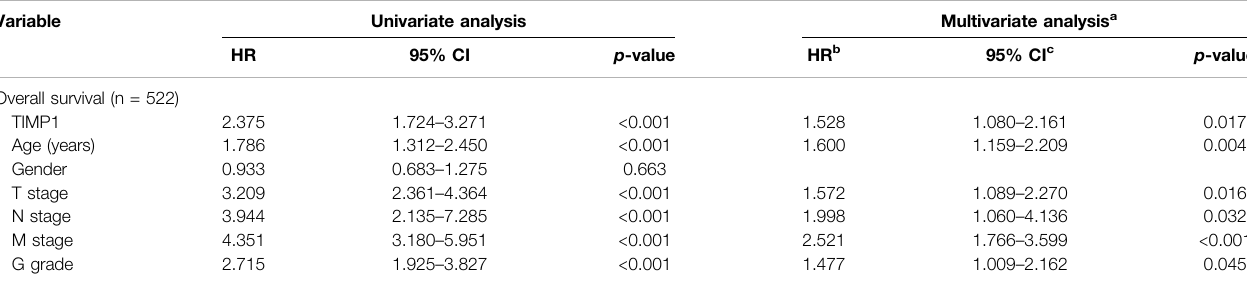
TABLE 2 | Univariate and multivariate analyses of TIMP1 mRNA level and patient overall survival. Variable Univariate analysis Multivariate analysis